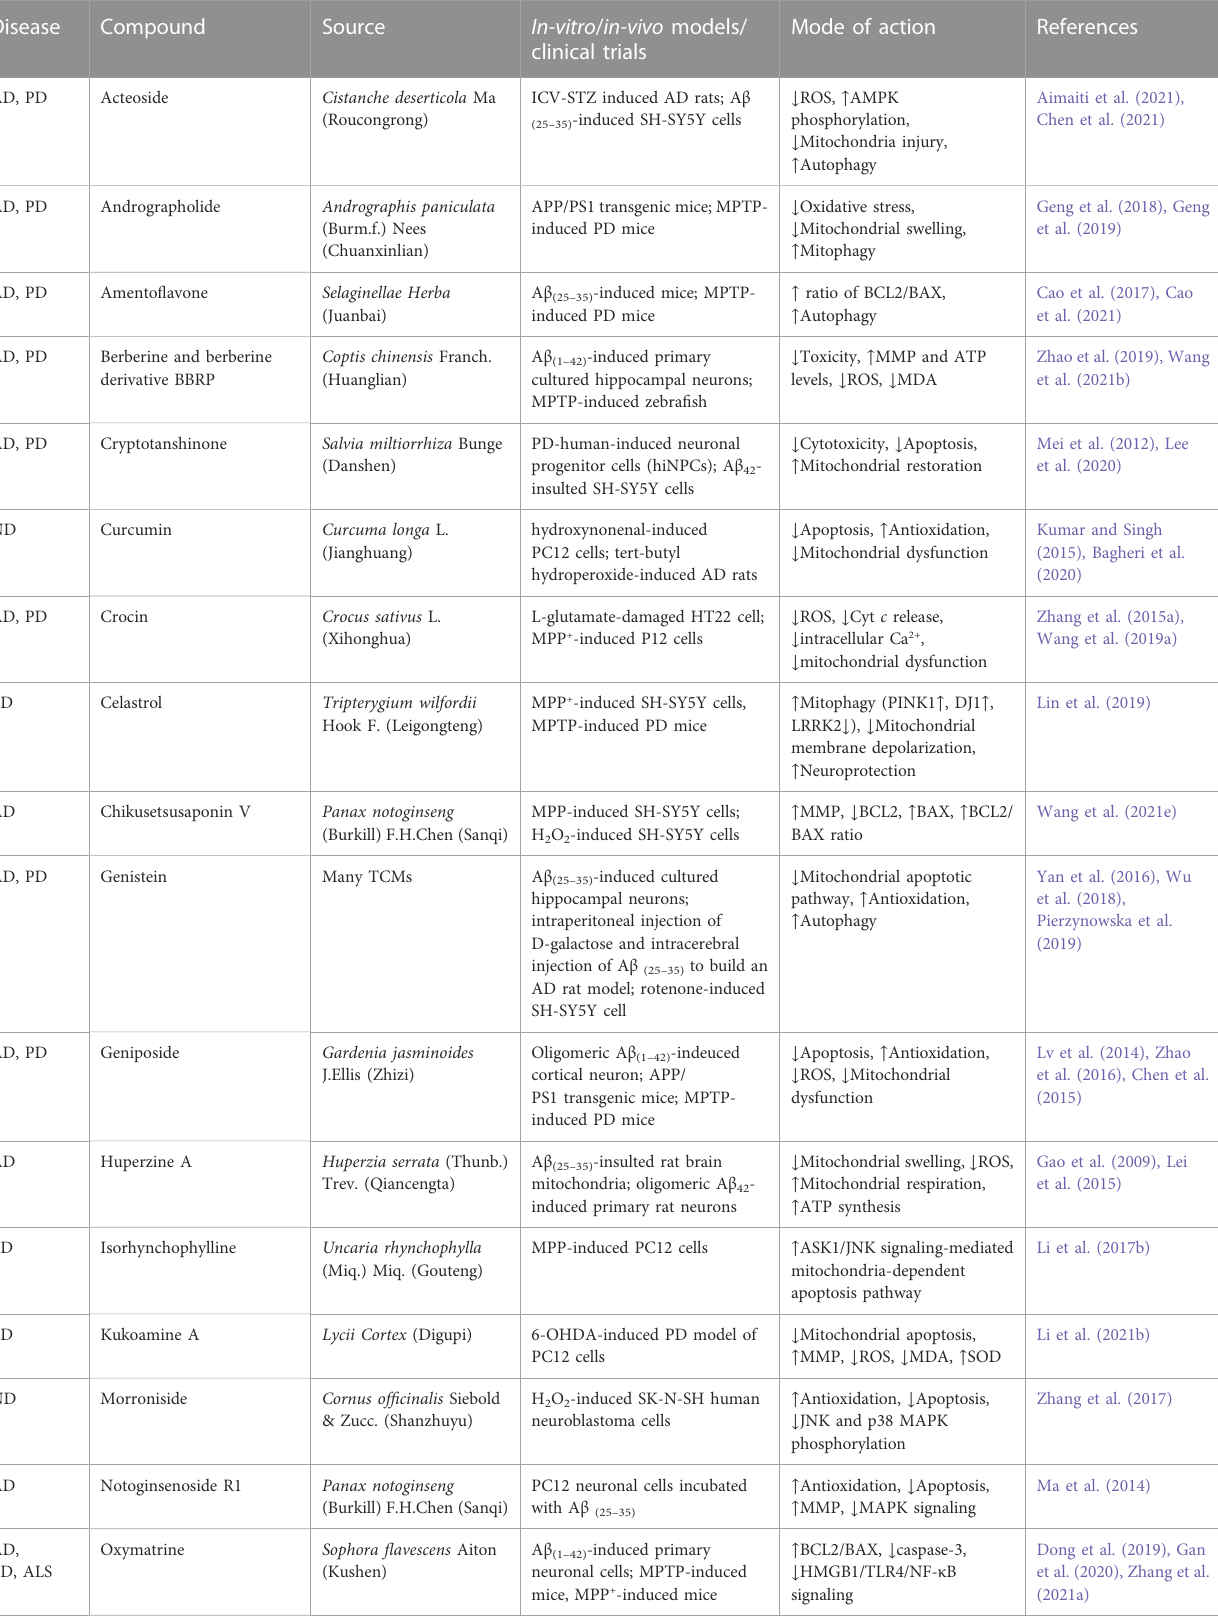
TABLE 3 List of monomeric compounds isolated from traditional Chinese medicines (TCMs) exerting anti-neurodegenerative disease (anti-ND) effects by regulating mitochondrial dysfunction.